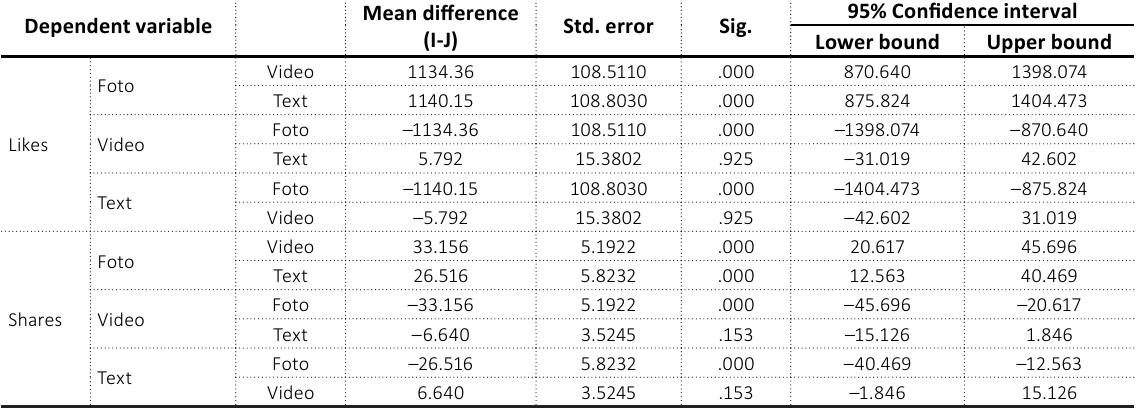
Table 8. Paired comparison of post types Dependent